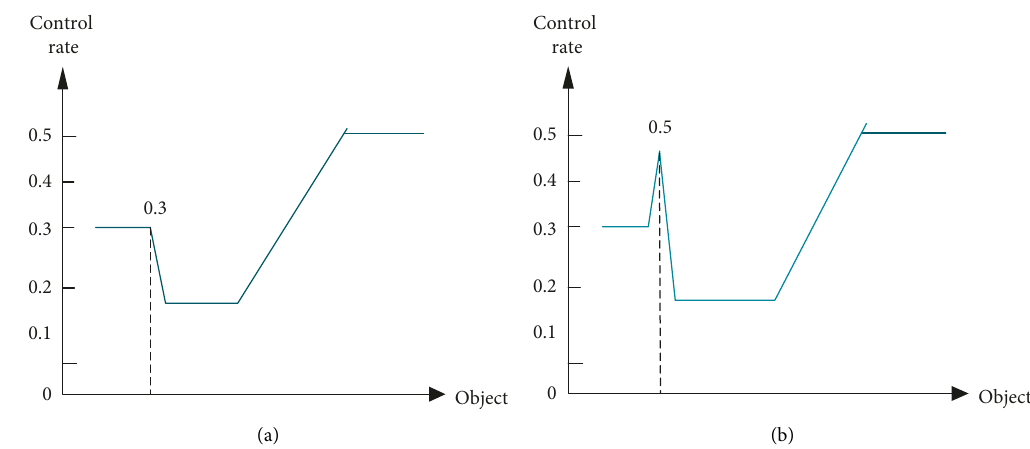
Figure 8: Curves of programmed rolling without and with inflection point control. (a) Curve of programmed rolling without inflection point control. (b) Curve of programmed rolling with inflection point control. Table 2: Comparison table of two kinds of variable-section automotive leaf springs after rolling hot straightening control system. Straightening function (%)